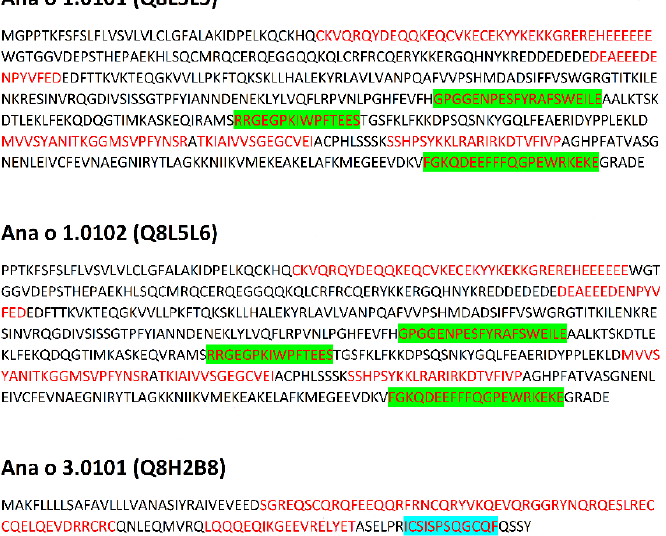
Figure 1. Sequences of allergens from Anacardium occidentale . Location of epitopes is indicated using red font. Green background indicates epitopes with highest ∑ A (range 1.6000–2.1000), blue background indicates epitopes with lowest ∑ A (range 0.1000–0.5999).